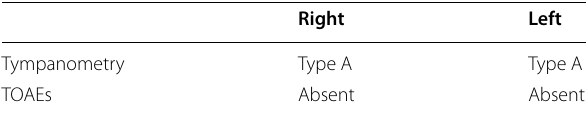
Table 1 Results of the tympanometry and TEOAEs, November